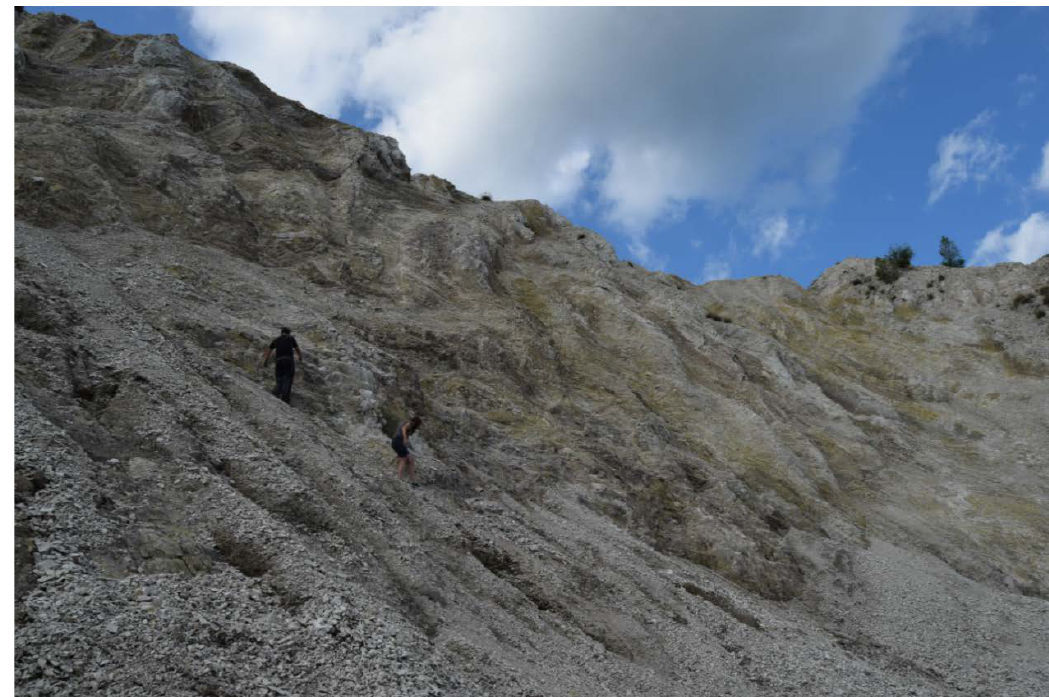
Figure 5. A quarry located in the Carpathians, Sibiciu de Sus, Romania—a possible source of airborne microfossils. Photo courtesy of Emilia Tulan.